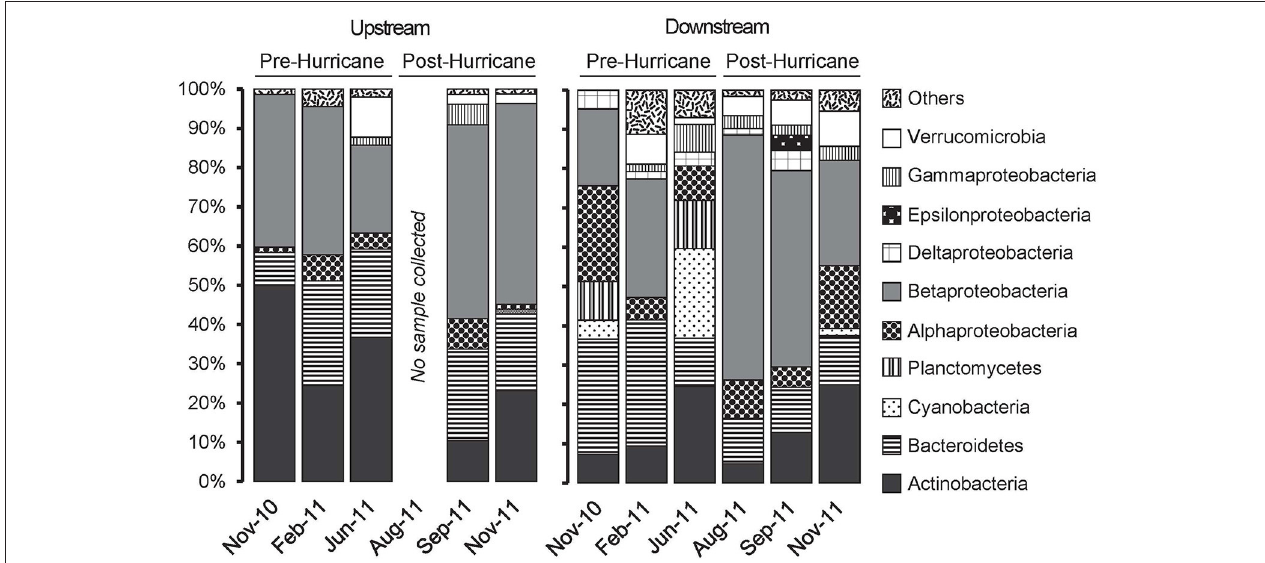
FIGURE 3 | Tar River clone libraries from November 2010 to November 2011. Actinobacteria is in dark gray, Betaproteobacteria is in light gray, and Verrucomicrobia is in white. “Others” include Armatimonadetes , Chlorobium , Chloroflexi , Spirochaetae as well as candidate phyla OD1, OP3, OP11, TM6, and TM7.